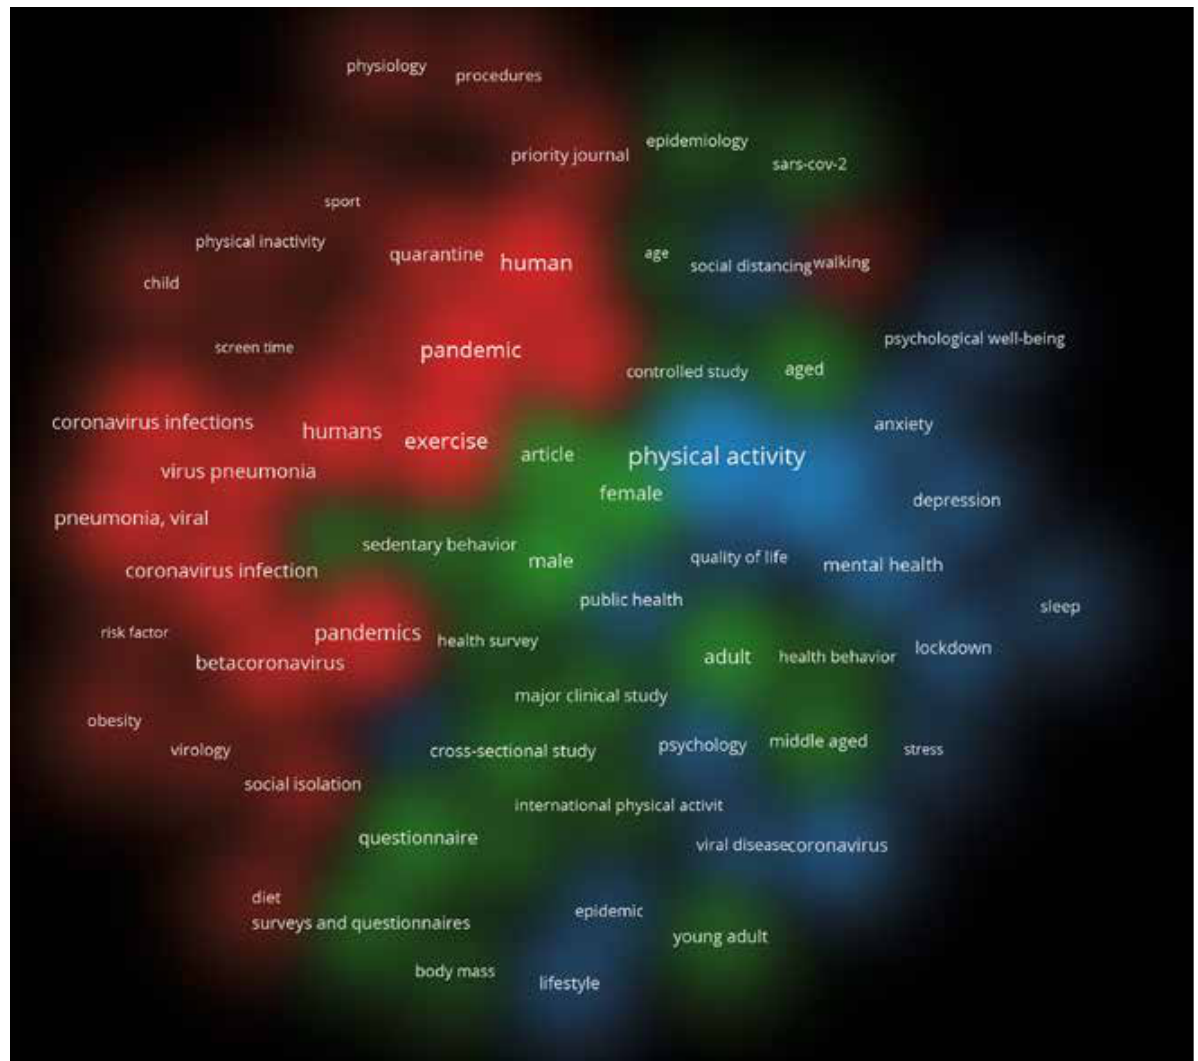
Figure 2. Fronts in research on physical activity in the COVID-19 context (co-word analysis, cluster density visualisation, weights – citations): Source: Own study based on data retrieved from Scopus and analysed with VOSviewer (15 January